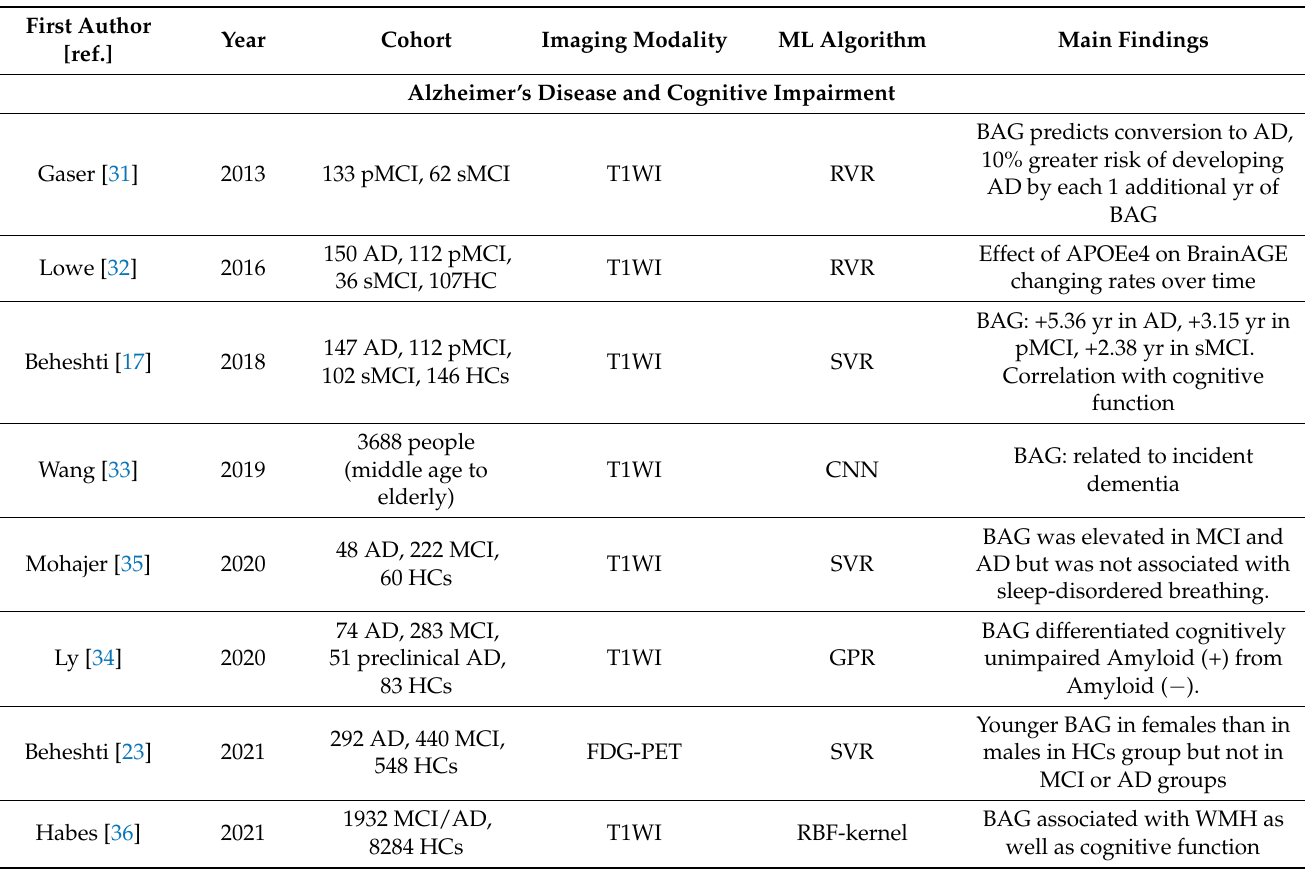
Table 1. Neuroimaging-based brain age studies for dementia, cognitive impairment, and other neurological